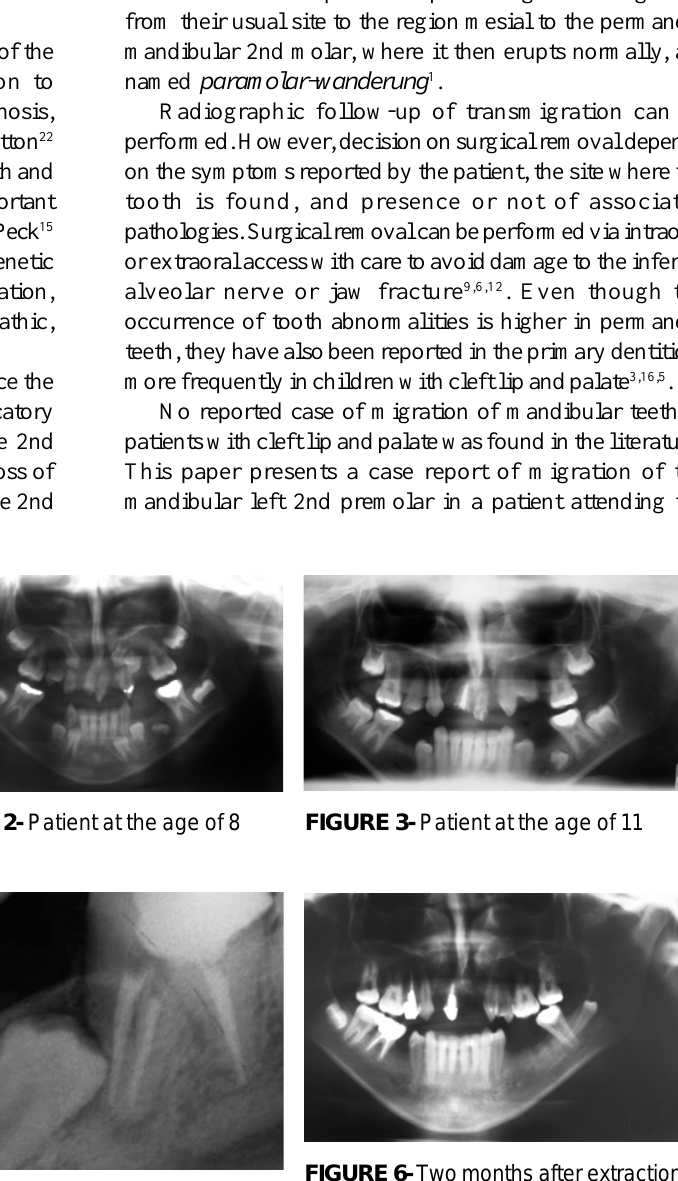
FIGURE 5- Extraction of the mandibular left 1st molar due to resorption of the mesial root at the age of 15